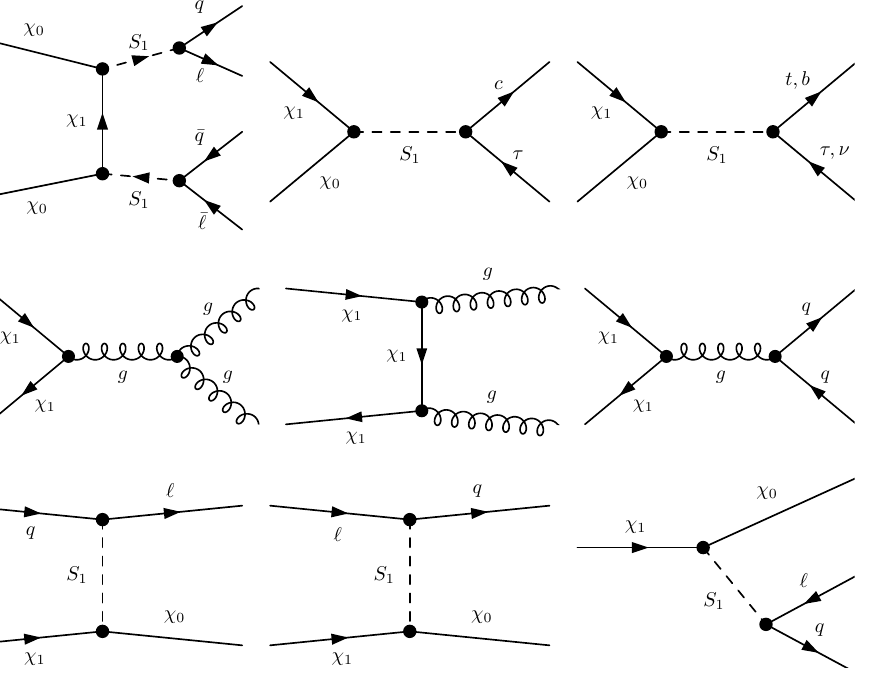
Figure 13 . Representative Feynman diagrams of processes contributing to the DM relic density. We show contributions from χ 0 self-annihilations (first diagram of the top row), χ 0 χ 1 co-annihilations (two last diagrams of the top row), χ 1 self-annihilations into quarks and gluons (second row) and those additional diagrams for CDFO through χ 1 q → χ 0 ‘ , χ 1 ‘ → χ 0 q , and non-prompt χ 1 decays (bottom